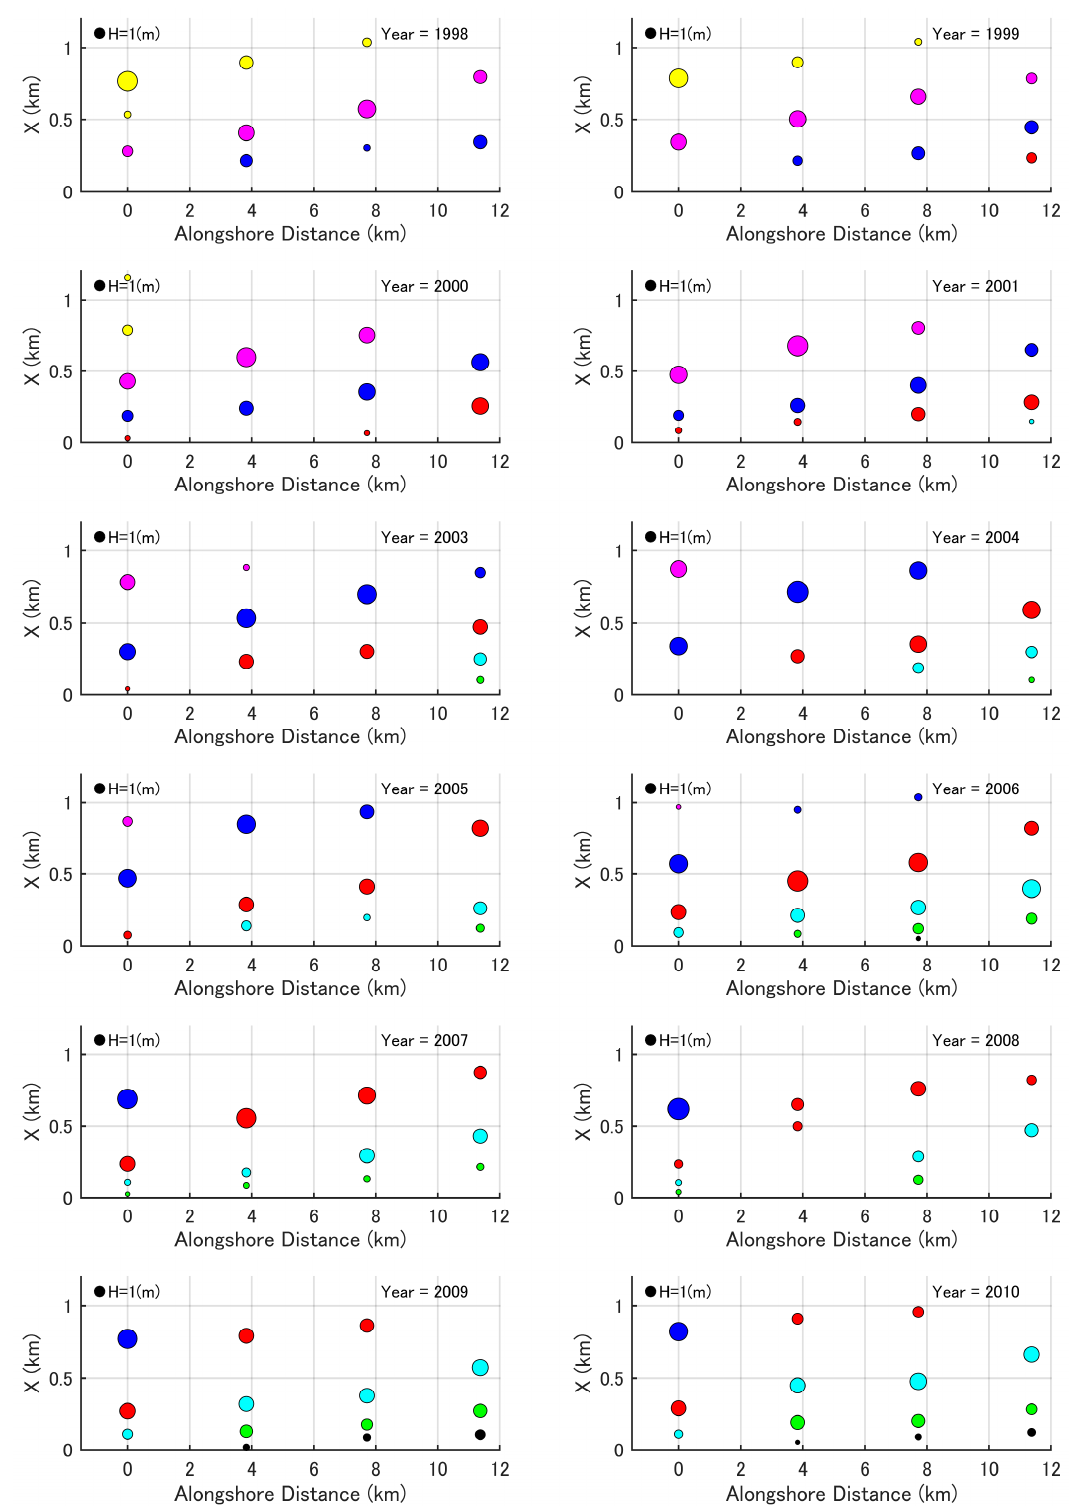
Figure 15. Comparison of the plan shape of the crest lines.